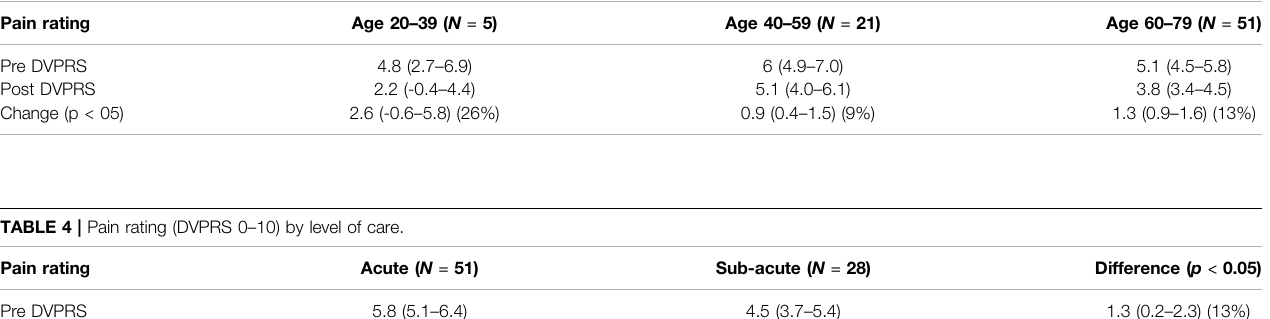
TABLE 3 | Pain rating (DVPRS 0 – 10) by age groups.